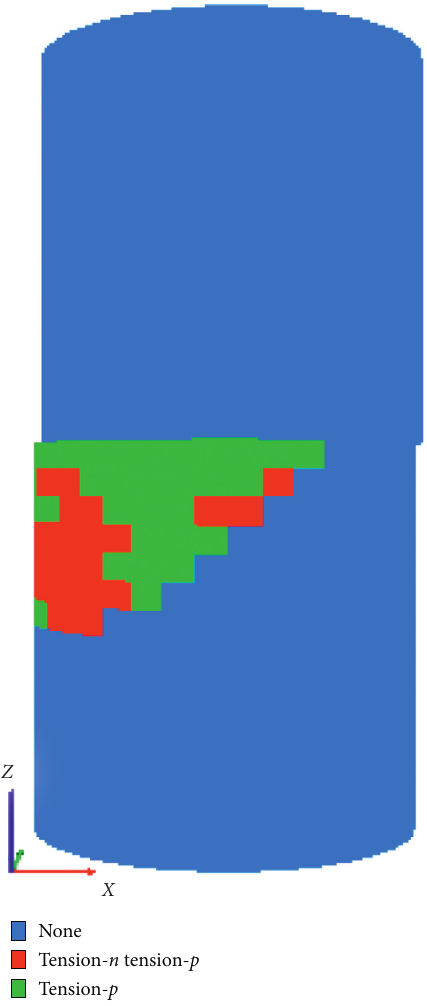
Figure 11: Plastic zone distribution in the